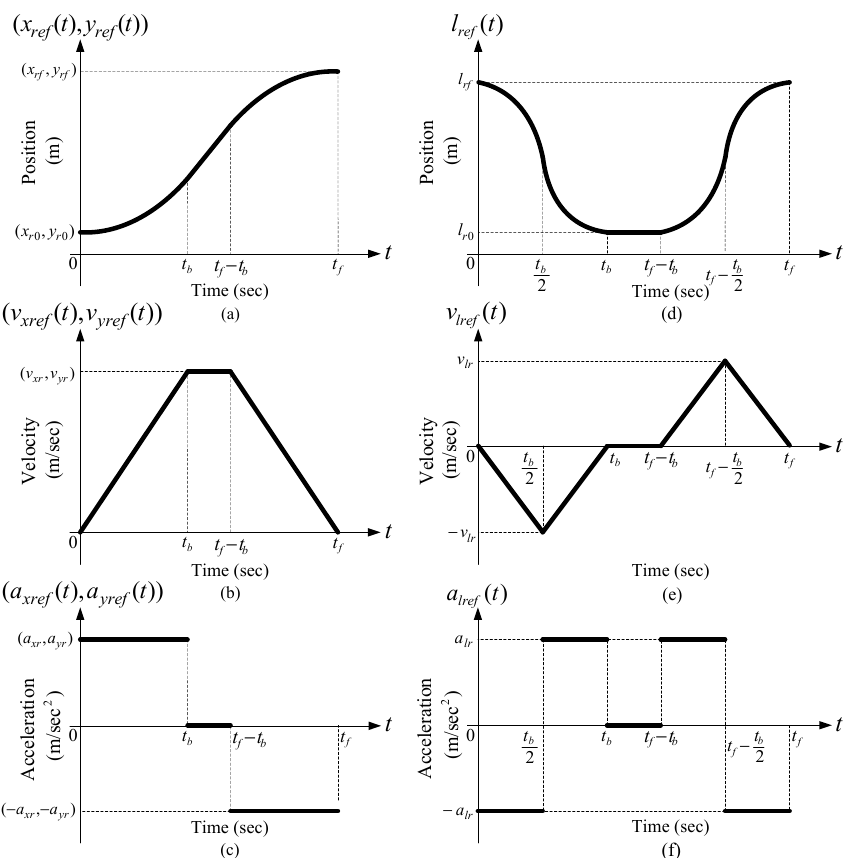
Figure 4. Sensors 2019 , 19 , x FOR PEER REVIEW